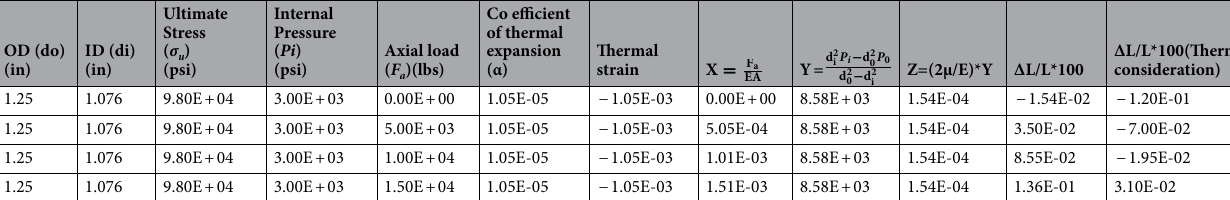
Table 19. CT strain analysis for the QT800 during the nitrogen shot operation.